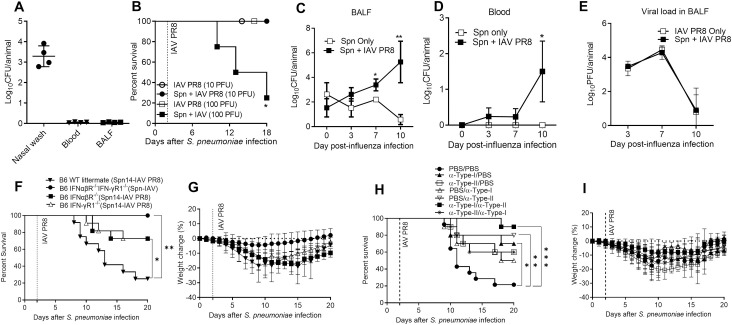
Effects of type-I and type-II IFNs during colonization with serotype-14 S. pneumoniae followed by superinfection with PR8 influenza virus.(A) C57BL/6 mice were colonized with 2x106 CFU of serotype 14 S. pneumoniae and bacterial burdens in the nasal washes, blood and BALF were determined two days later. (B) On Day 2 post-colonization, mice were infected with 10 or 100 PFU of PR8 influenza virus and survival was monitored. Mice were also infected with influenza virus only to ensure that mortality was not due to viral infection. On the indicated days post-influenza virus co-infection, bacterial burdens were assessed in the BALF (C) and blood (D) and influenza virus titers were determined in the BALF (E). A minimum of 4 and 5 mice were used in each experimental group to assess bacterial burden and survival, respectively. Statistical analyses were performed by two-way ANOVA. *P<0.05; **P<0.01. (F,G) C57BL/6 WT (n = 12), C57BL/6 IFNαβR-/ (n = 11), IFN-γR1-/- (n = 11) and IFNαβR-/-IFN-γR1-/- (n = 8) mice were monitored for (F) survival and (G) weight loss following intranasal infection with 2 x 106 Spn on Day 0 and 100 PFU of PR8 IAV on Day 2. (H,I) C57BL/6 WT mice were infected with S. pneumoniae serotype 14 on Day 0 and influenza virus on Day 2. Mice received PBS, α-IFNαβR mAb or αIFN-γ mAb early after infection (Days 0, 1, 2, and 3) together with PBS, α-IFNαβR mAb or α-IFN-γ mAb late after infection (Days 4, 6, 8, 10 and 12) as indicated in the figure. 10 mice/group, except the PBS control group which included 14 mice. All survival data were analyzed by log-rank Mantel-Cox test. *P<0.05; **P<0.01, ***P<0.001.